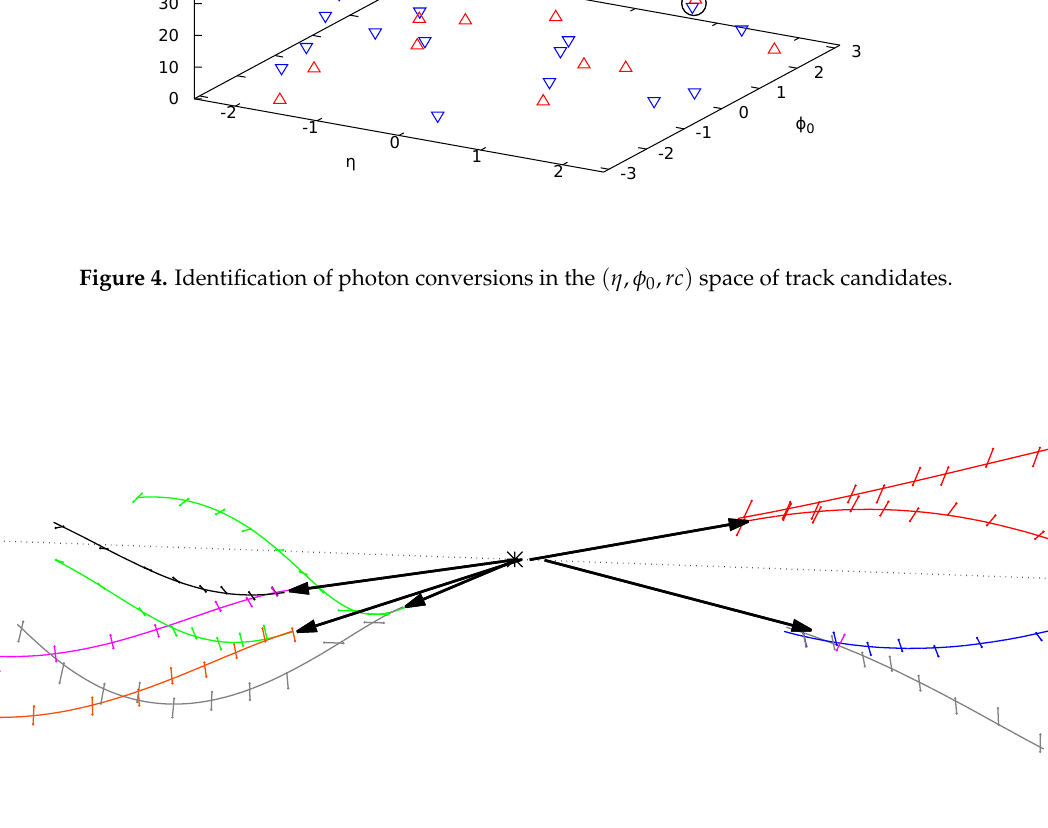
Figure 5. Hits and track candidates and their trajectories, corresponding to electron or positron tracks (colored curves) coming from photon conversions (thick black arrows). The event is identical to the one displayed in Figure